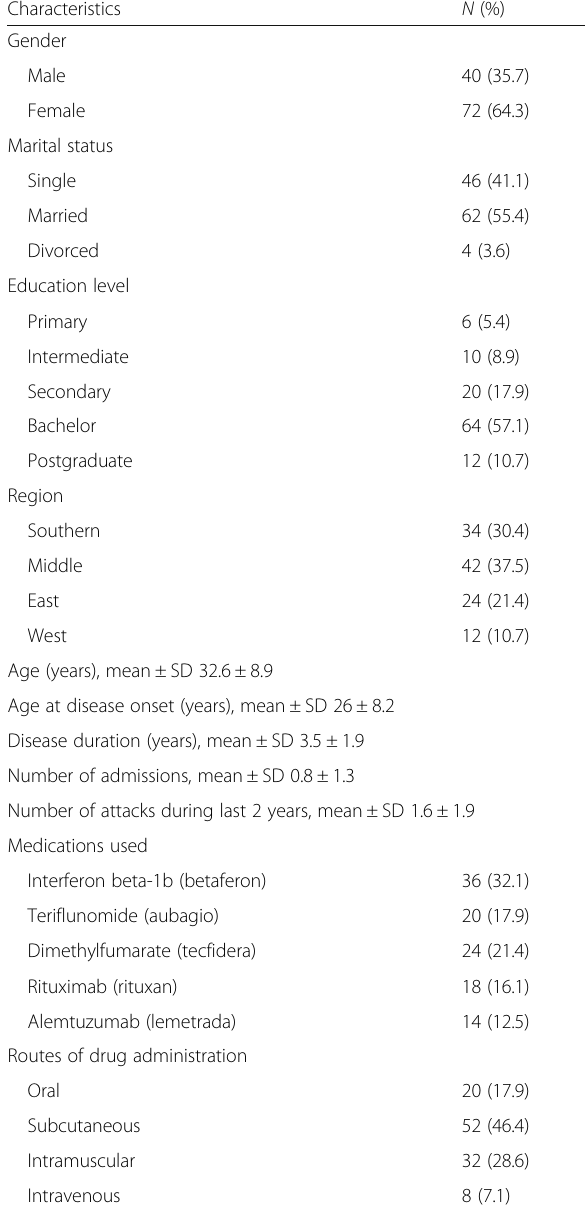
Table 2 Comparison of MS patients ’ characteristics according